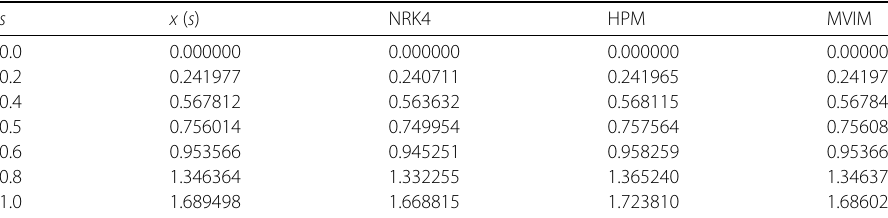
Table 3 The results of different methods for Example 2, α = 1